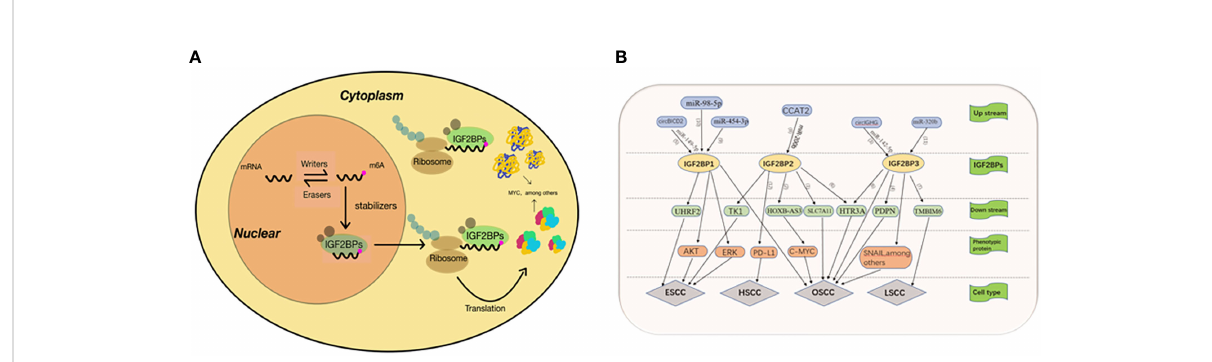
FIGURE 2 (A) 1GF23Ps-mediated regulation of m6A modi fi ed mRNA. The mRNA is methylated by a methyltransferase complex, which is composed of METTL3, METTE14 and WTAP. The original RNA with m6A modi fi cation was preferentially recognized by IGF2BPS. IGF2BPs protects target mRNAs from degradation by recruiting mRNA stabilizers, such as HuR and Matri3, while promoting mRNA transfer to cytoplasm and translation. (B) (1)IGF2BP2 promotes the development of OSCC by enhancing the stability of SLC7A11 mRNA. (2) Hoxb-as3 interacts with IGF2BP2 to promote the stability of C-MYC, thereby promoting the proliferation and viability of OSCC cells. (3) Cure GHG manipulates IGF2BP3 through miR-142-35p, thus accelerating the progression of oral squamous cell carcinoma. Epithelial-mesenchymal transition was the main mechanism through which girlGHG/IGF2RP3 promotes metastasis of OSCC. (4) IGF2B3P3 binds to the PDPN mRNA to promote cell migration. (5) CirclCD2 can inhibit proliferation, migration and invasion of OSCC cells and increase cell apoptosis by regulating miR-149-5p/IGFBPI axis (6) Linco1305 mabilizes HTR3A mRNA through interacting with IGF2BP2 and IGF2BP3 and thereby promotes metastasis and proliferation of ESCC (7) RIMIS facilitates laryngeal squamous cell carcinoma progression by regulating TMBIM6 stability through IGF2BP3 dependent. (8) CCAT2 binds to miR- 2006 and reduces its expression, leading to up-regulation of IGF2BP2, which enhances the stability of TKI mRNA and its expression by recognizing meA modi fi cation of TK1. (9) MiR-454-3p targets IGF2BPI through ERK and AKT signaling pathways and inhibits the proliferation, migration and apoptosis of ESCA cells. (10) IGF2BPI and UHRF2 promote ESCC invasion and proliferation, and inhibit apoptosis through miR- 98-5p mediation (11) IGF2BP3 is positively correlated with: I INC00460, which promotes the progress of TSCC through LINC00460/miR-320b/ IGF2RP3 axis (12) IGFBP2 may promote the development of hvnoonharyngeal cancer mediated by the PD-1/PD-L1